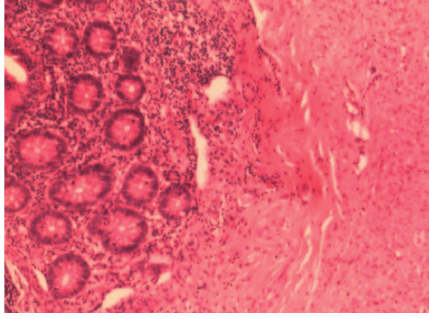
Figure 1: Pathological biopsy specimen shows acutely inflamed appendix.